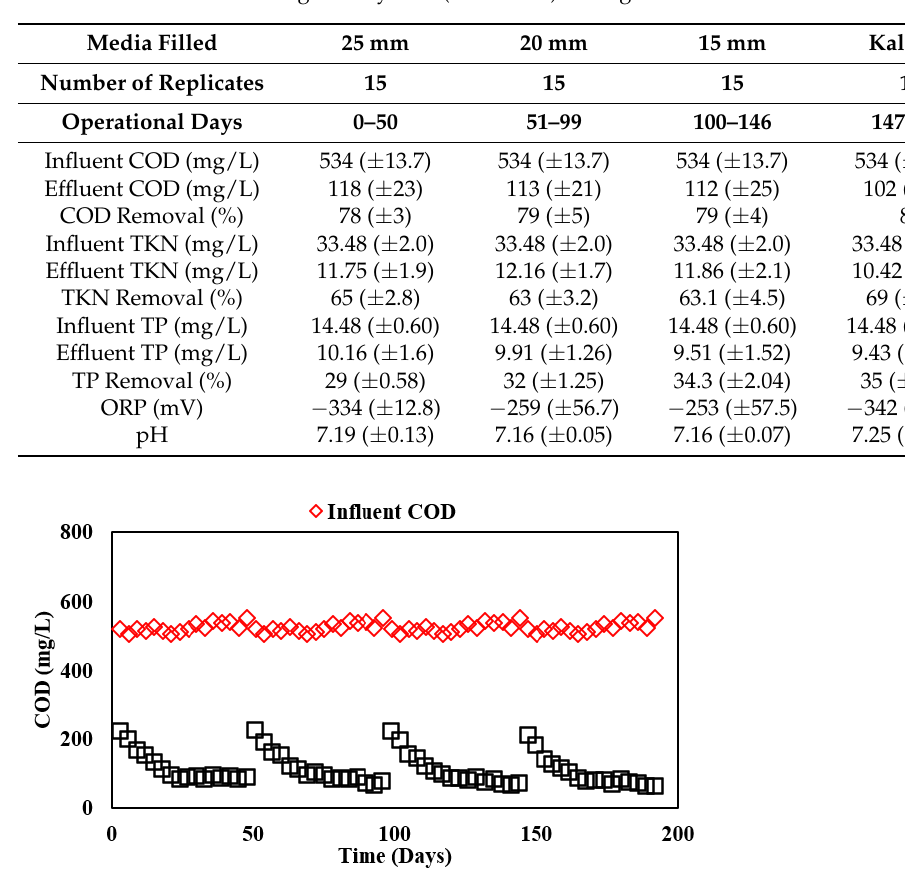
Table 4. Performance of integrated system (ABR + AF) during Phase II.